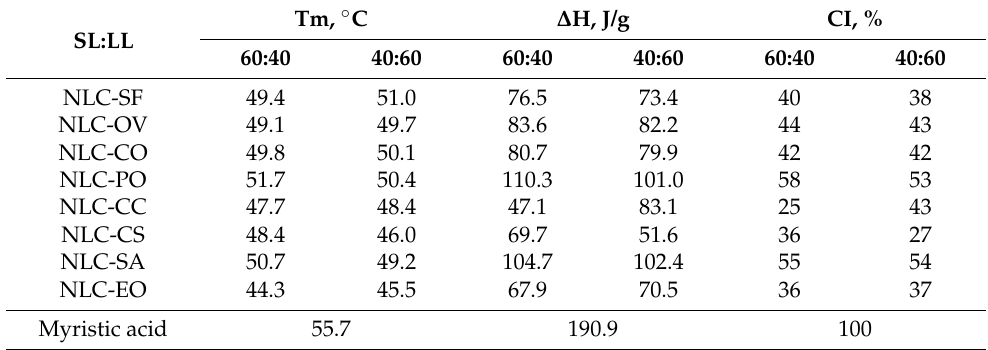
Figure 4. DSC thermogram: ( a ) for MA and NLC-NPO systems with two SL:LL ratios; ( b ) for pure oils. Table 4. Melting temperature (Tm, ◦ C), enthalpy ( ∆ H, j/g), and crystallinity index (CI, %) of NLC- NPOs with different SL:LL